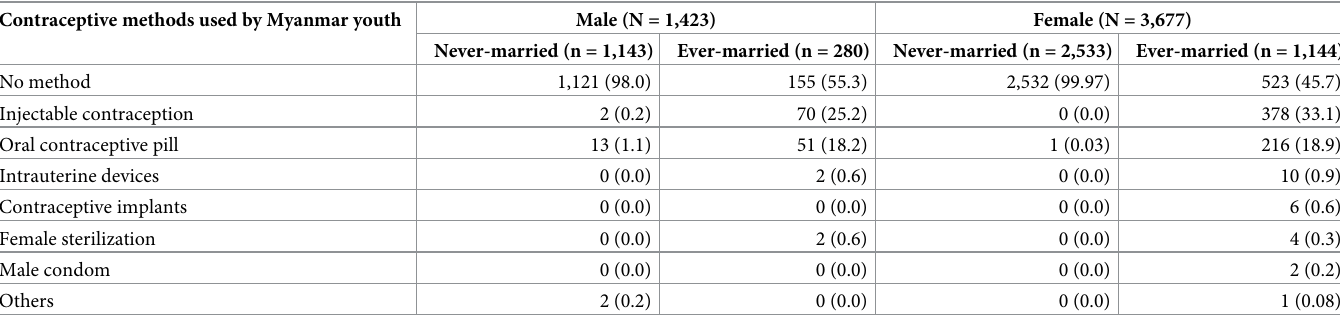
Table 3. Types of modern contraceptive methods used by youth in Myanmar. Contraceptive methods used by Myanmar youth